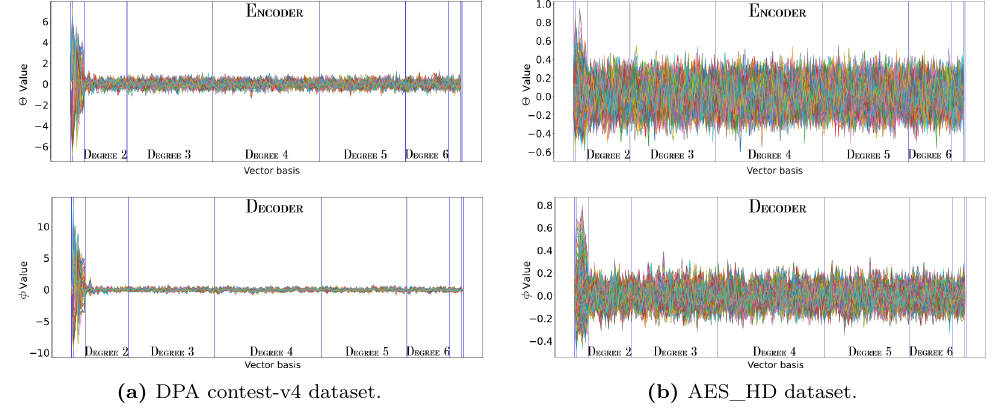
Figure 4: Weight visualization of 50 time samples assessing the suitability of our generative model to retrieve the leakage